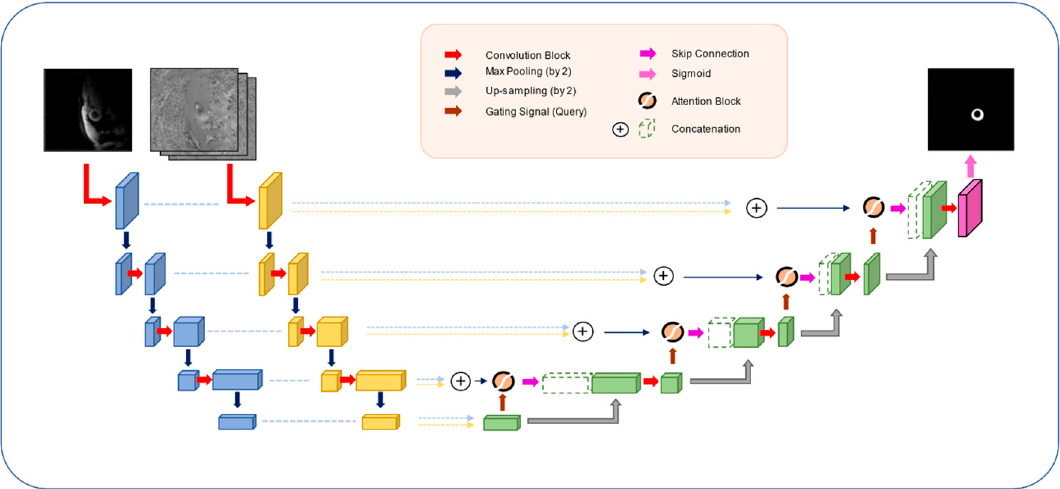
Figure 1. Network architecture of our proposed myocardium segmentation in three-directional cine multi-slice left ventricular myocardial velocity mapping (3Dir MVM) cardiac magnetic resonance (CMR) (i.e., model [d] in Section 2.2).